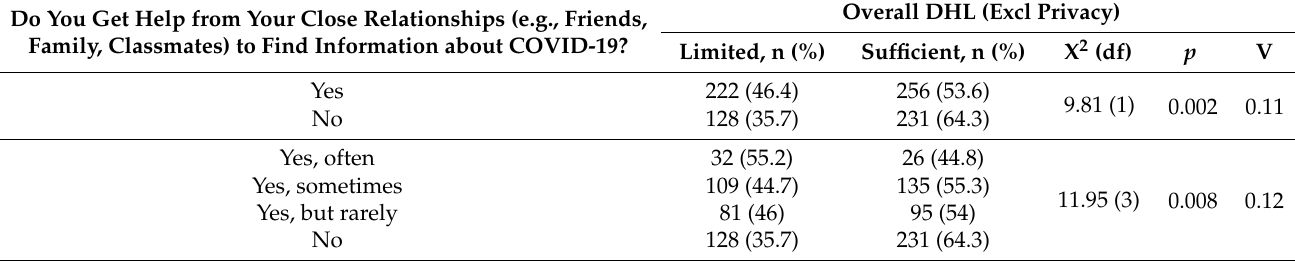
Table 4. Help from close relationships (n =